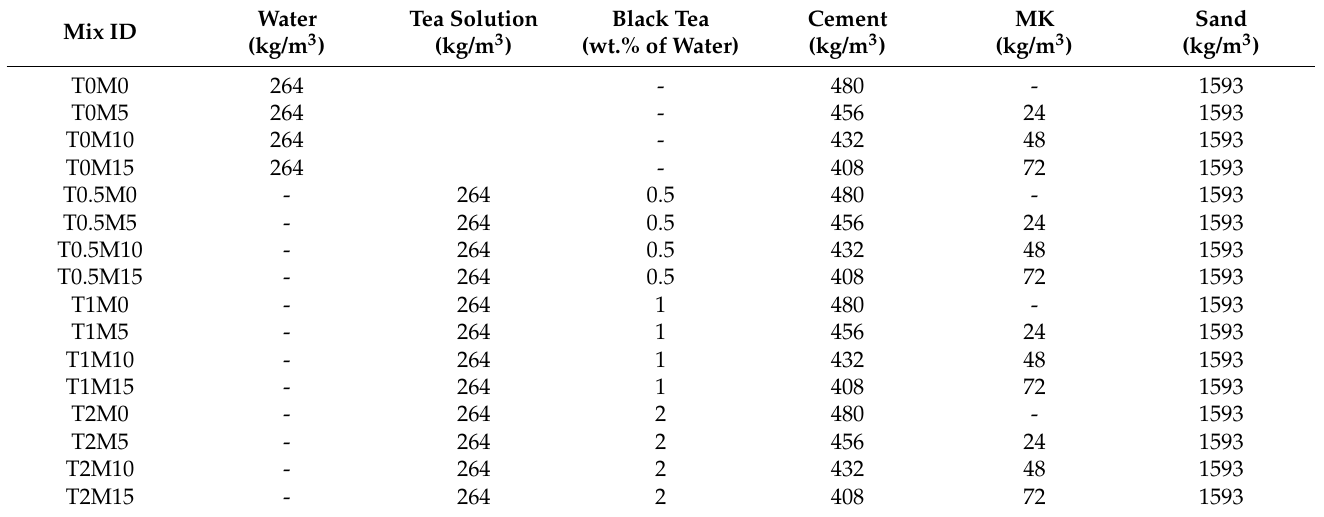
Table 2. Mix design of mortar